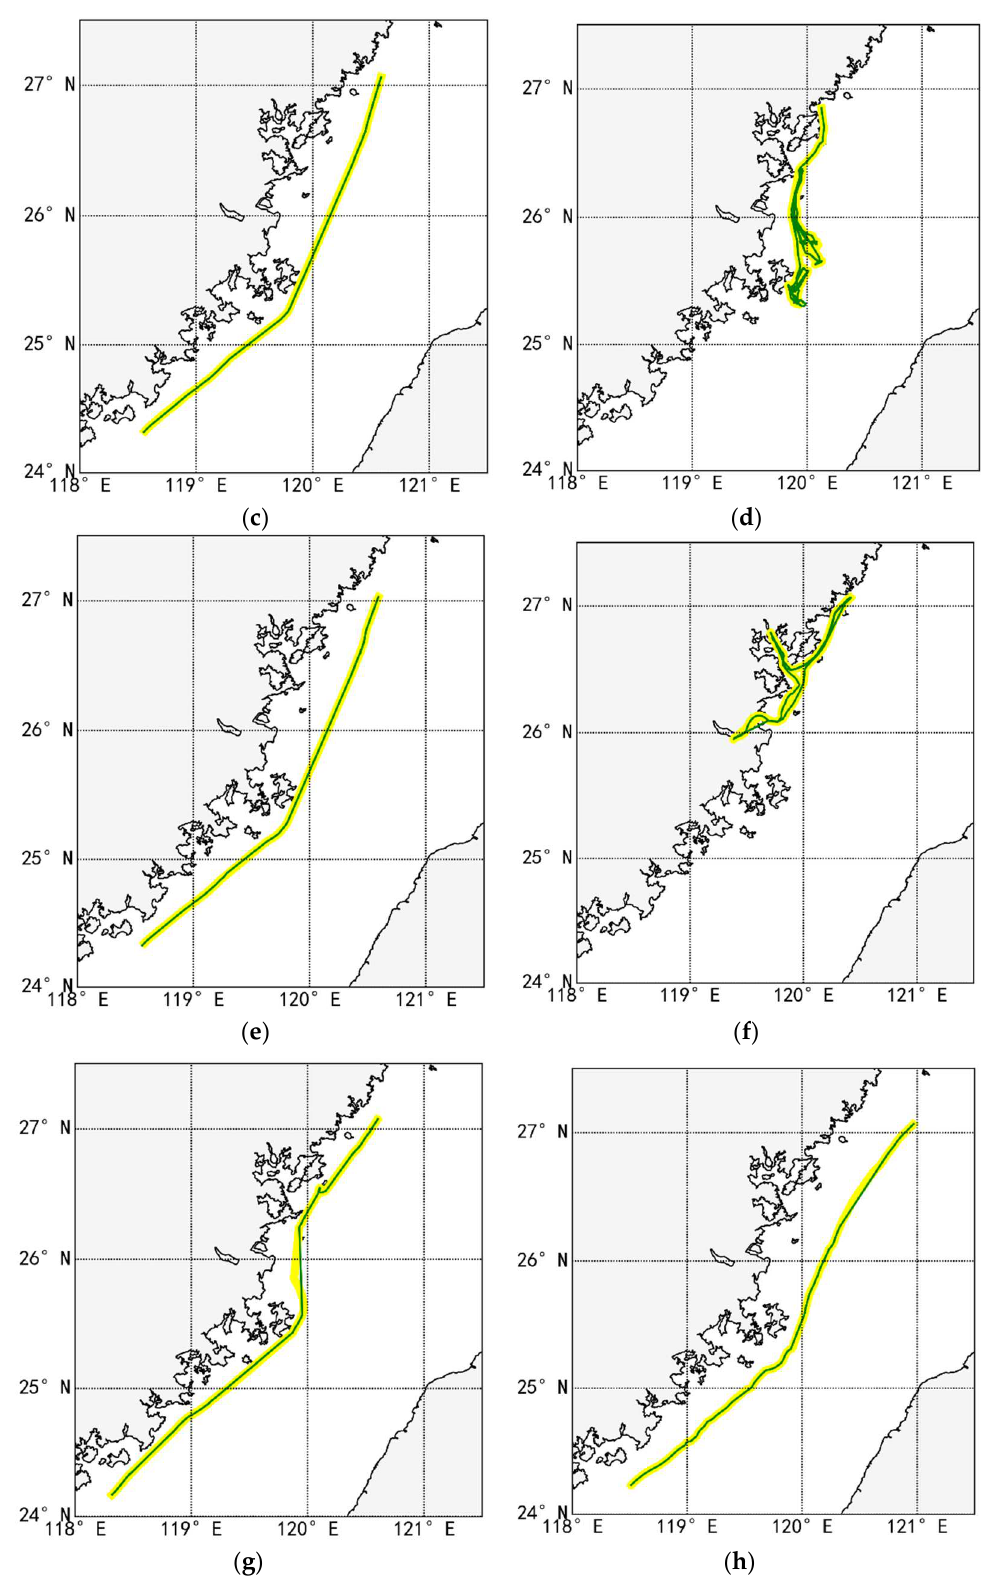
Figure 3. STCP trajectory diagram. ( a ) to ( h ) respectively represent the trajectory of the 8 pairs of accompanying ships in Table 3.